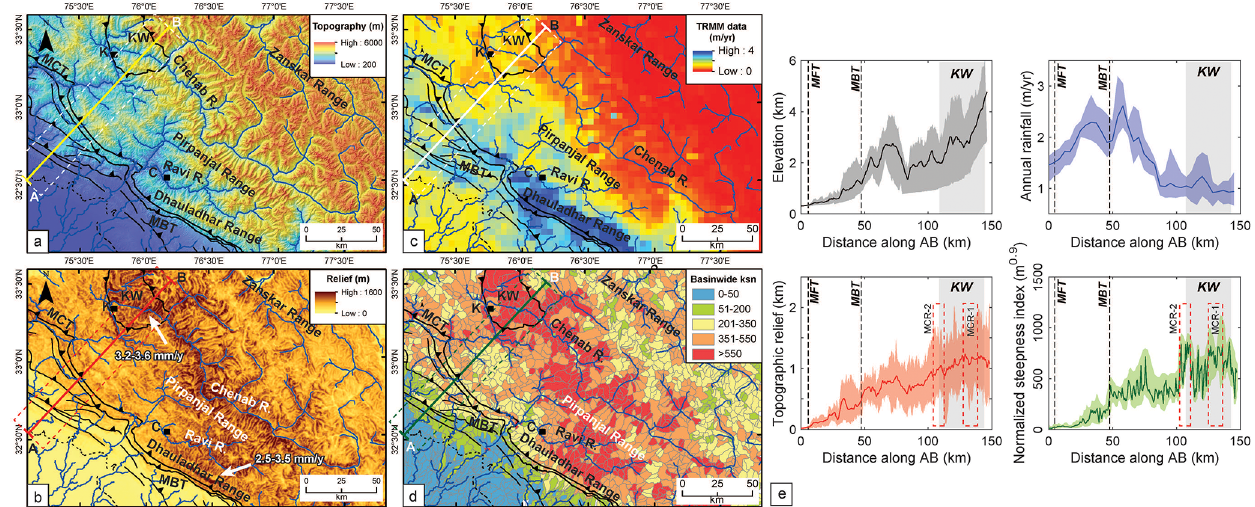
Figure 5. Regional variations in (a) topography, (b) topographic relief (moving window of ∼ 4km) (c) TRMM-derived rainfall (after Bookhagen and Burbank, 2006) and (d) basin-wide normalized steepness indices ( k sn value) of the region shown in the dashed box in Fig. 1a. The 12.5m ALOS PALSAR DEM, downloaded from https://asf.alaska.edu/ (last access: 18 December 2018), was used as the topography data. (e) Swath profiles (swath window: 50km) along the line AB (see Fig. 5a) demonstrate the orogen-perpendicular variations in elevation, rainfall and ksn value. The KW is characterized by high elevation, high relief and high steepness, but low rainfall.